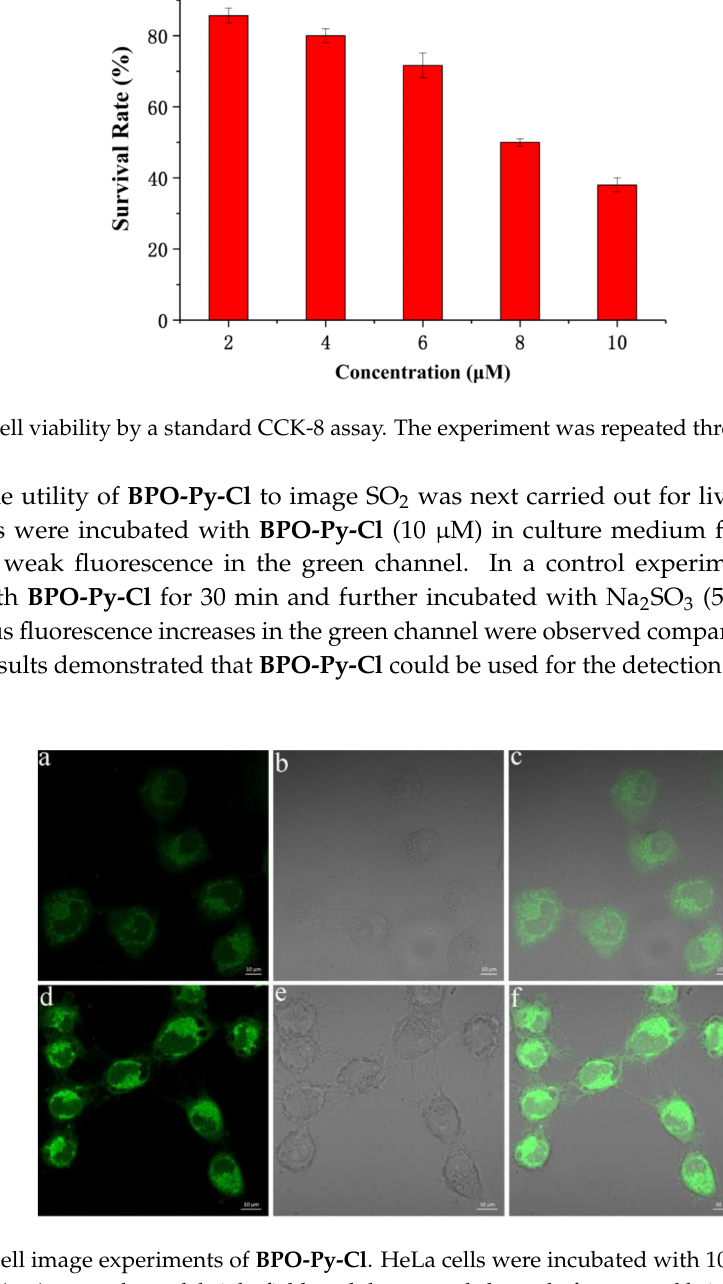
Figure 8. Cell image experiments of BPO-Py-Cl . HeLa cells were incubated with 10 µ M BPO-Py-Cl for 30 min, ( a – c ) green channel, bright field, and the merged channel of green and bright field channels. HeLa cells were incubated with 10 µ M BPO-Py-Cl for 30 min, then washed with PBS and incubated with SO 3 2 − (500 µ M) for another 90 min; ( d – f ) are the green channel, bright field, and the merged channel of green and bright field